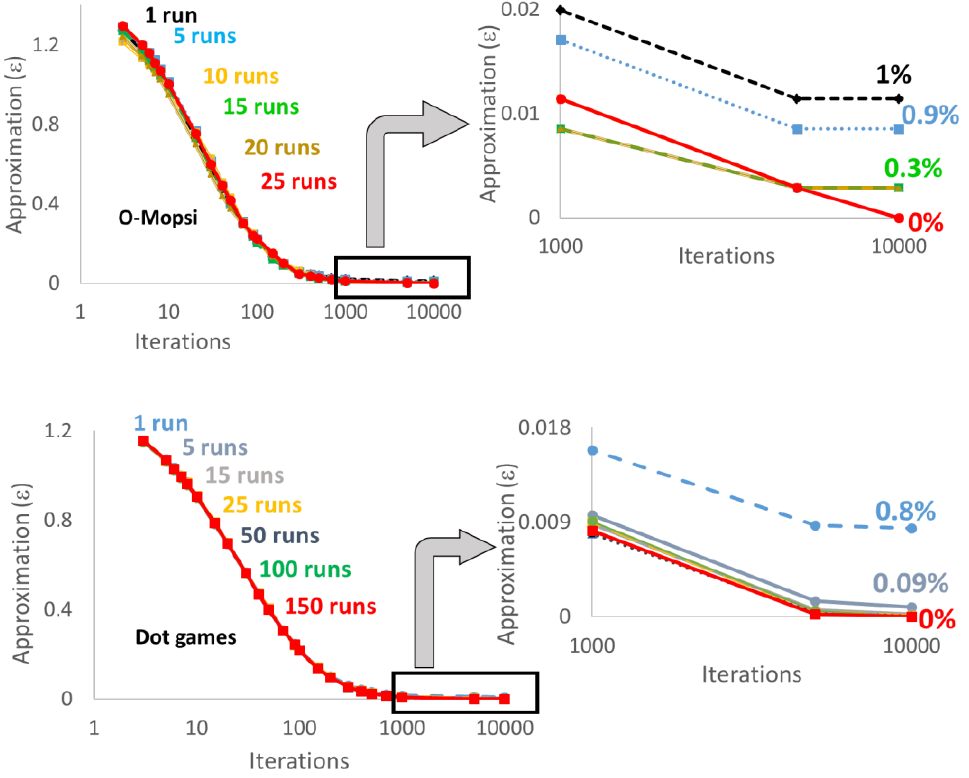
Figure 17. Total amount of work.